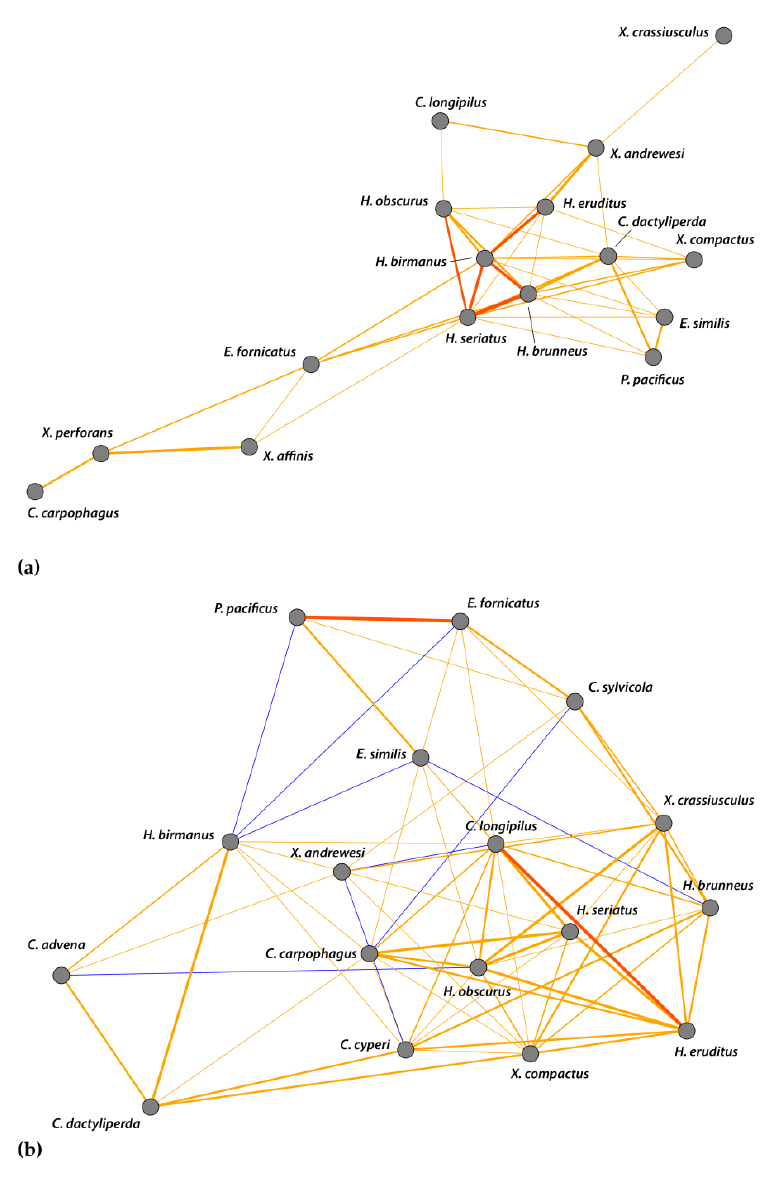
Figure 8. Correlation network of log-transformed abundance data for scolytine species at ( a ) the Kaua ʻ i Coffee Company and ( b ) Moloa ʻ a Bay Coffee. Thickness of edges (i.e., lines connecting nodes) varies with strength of correlations; network shows only R 2 > 0.35. Weak trends (0.1 > p > 0.05) are yellow (positive) or blue (negative), and significant positive correlations ( p < 0.05) are orange. There are no significant negative correlations.